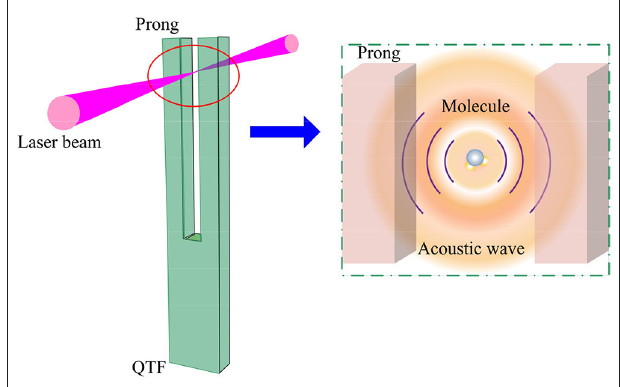
FIGURE 2 | Schematic diagram of a QTF, a laser and an acoustic wave in a QEPAS